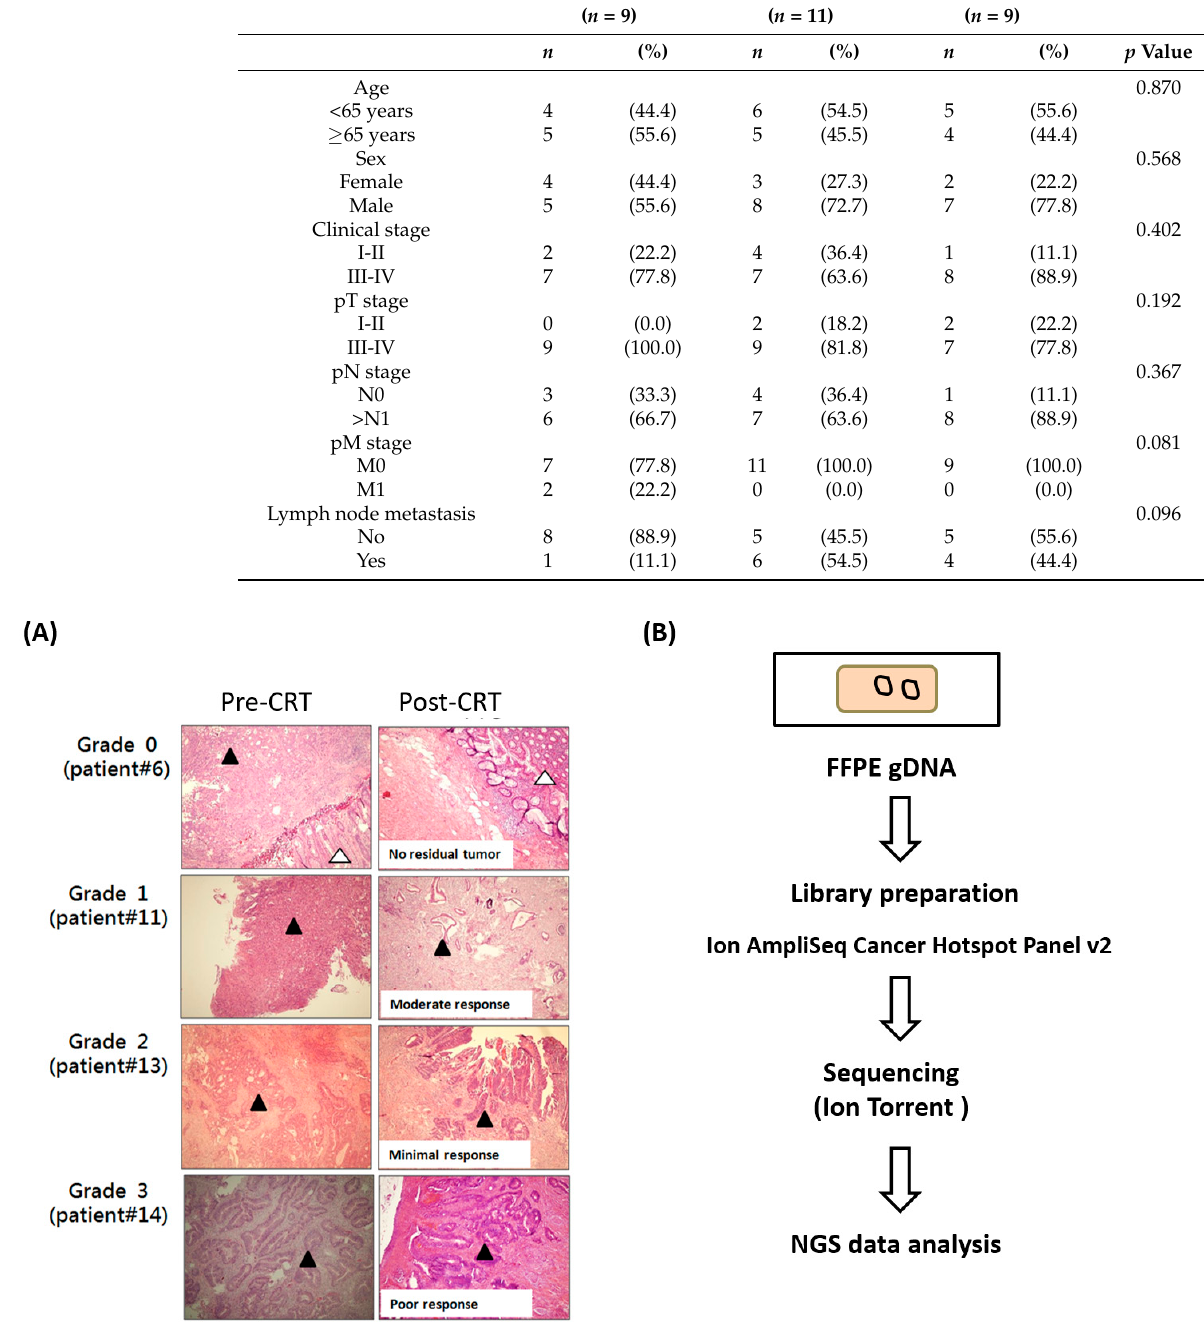
Figure 1. Identification of gene variants in rectal carcinoma through NGS. ( A ) Histopathological ex- amination of biopsy specimens collected from patients with rectal carcinoma before nCRT (left panels). Histopathological examination of surgery specimens collected from patients with rectal carcinoma after nCRT (right panels). The black triangle indicates tumor cells, and the white triangle indicates the normal tissue. The response to nCRT was determined on the basis of the tumor regression grade. The image of specimens was determined through the microscope (magnification with 40 × lens). ( B ) Targeted NGS workflow. Ten nanograms of genomic DNA was used for AmpliSeq cancer panel library preparation. Ion and high-throughput sequencing was performed using ion Torrent. Table 1. Clinicopathological characteristics of 29 patients with rectal carcinoma.